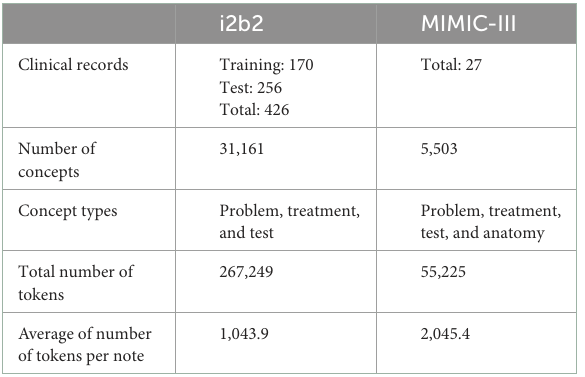
TABLE 1 Details of the i2b2 and MIMIC-III